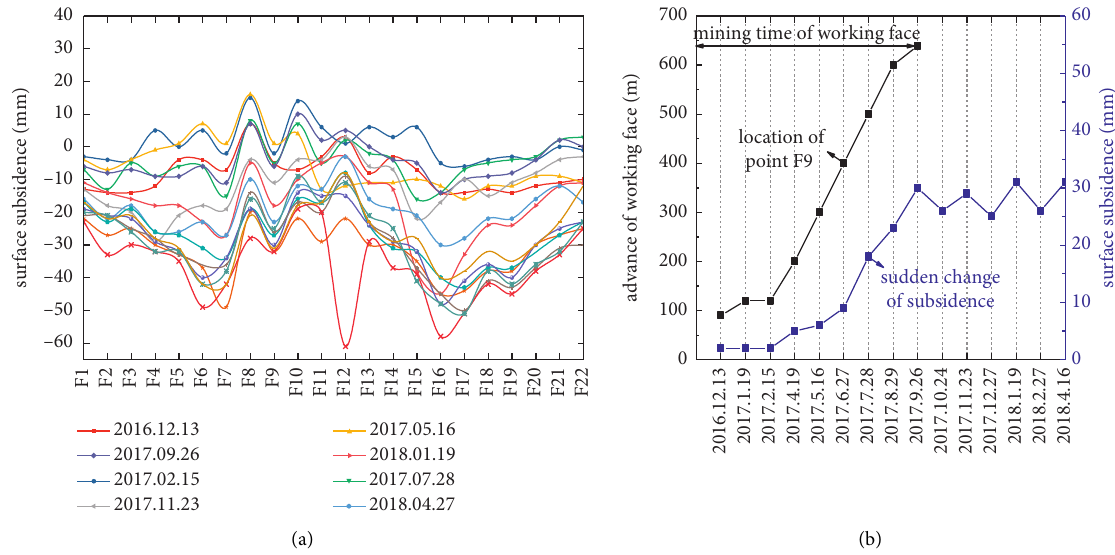
Figure 7: Surface subsidence values (a) on line F for each time period and (b) for each time period at measuring point F